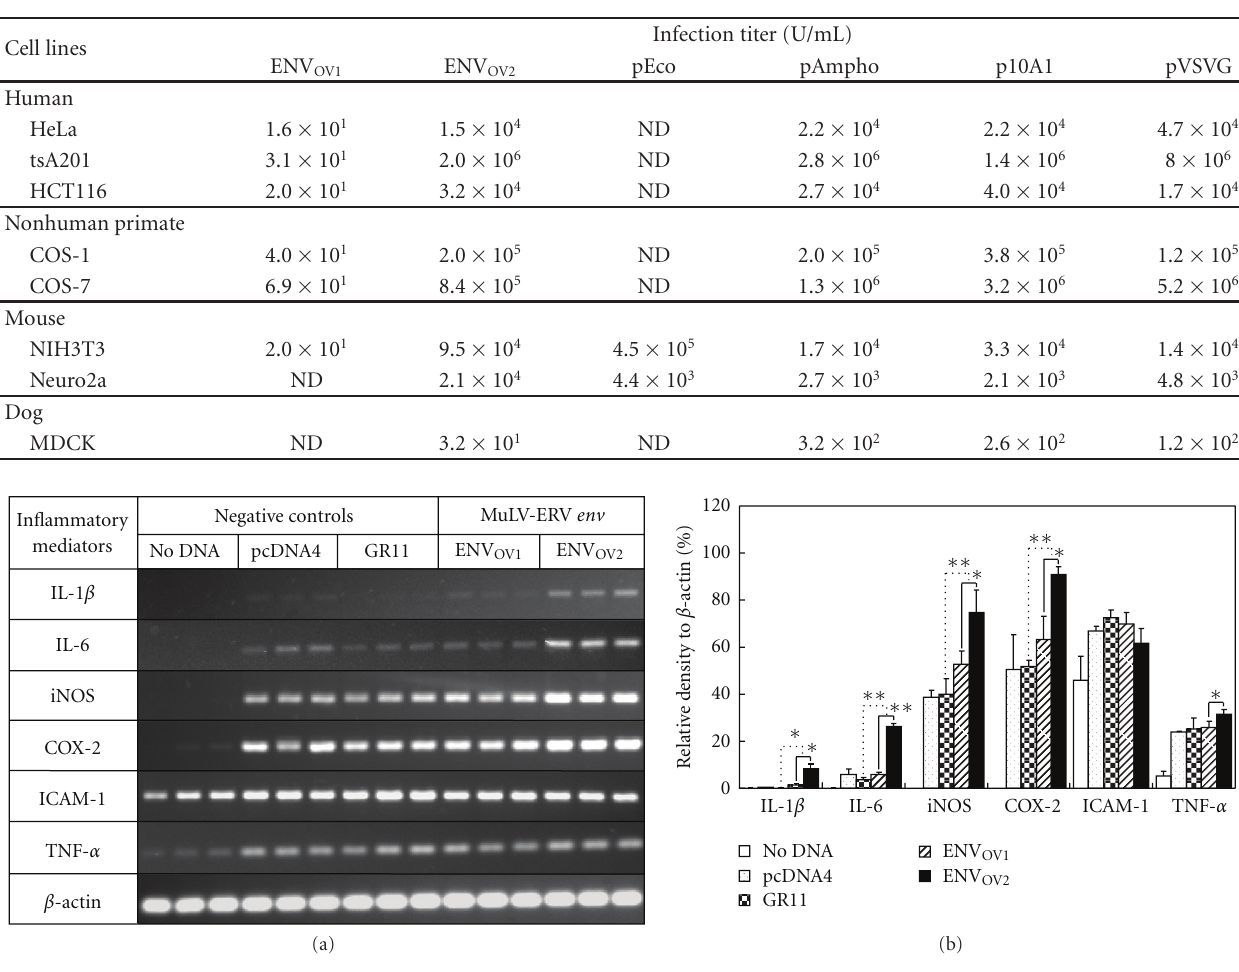
Table 1: Tropism trait and infectivity of the ENV OV1 and ENV OV2 polypeptides. Infection titer unit (U/mL): number of LacZ positive cells per mL of supernatant containing virus particles. ND: not detectable.